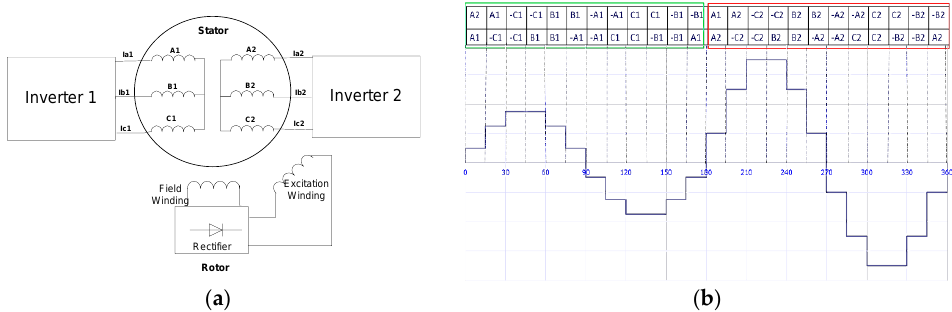
Figure 1. ( a ) Brushless dual inverter topology [11] and ( b ) magnetomotive force (MMF) plot for 24-slot stator windings.